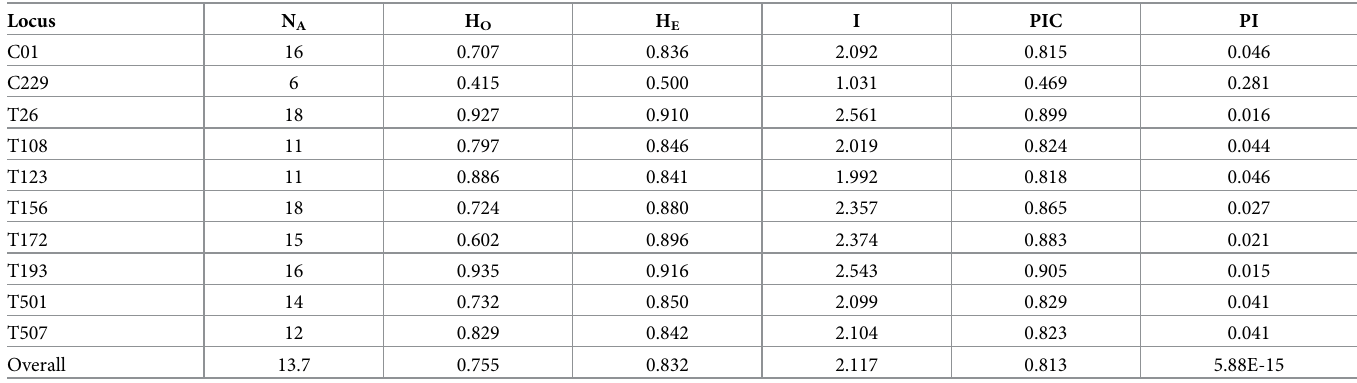
N A , number of detected alleles; H O and H E, observed and expected heterozygosity, respectively; I, Shannon’s Information Index; PIC, Polymorphic Information Content; PI, probability of identity.